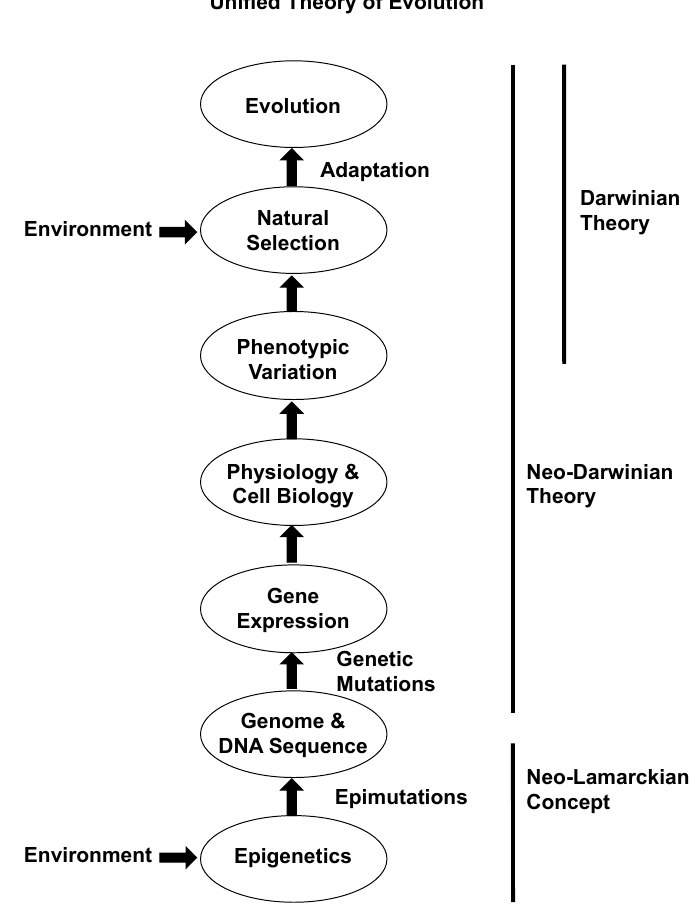
Figure 2. Schematic of the unified theory of evolution. No dominance is suggested by the appearance of specific circles (e.g., epimutations vs. genetics) such that all are equally important components. Modified from [74].